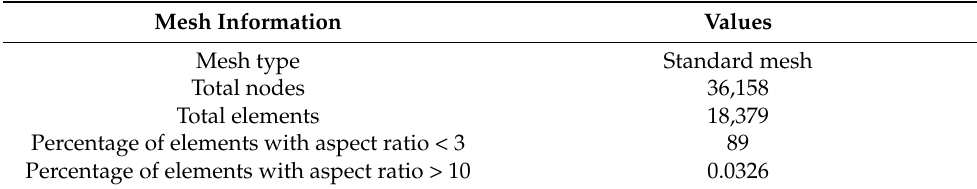
Table 6. Mesh used in the simulation.